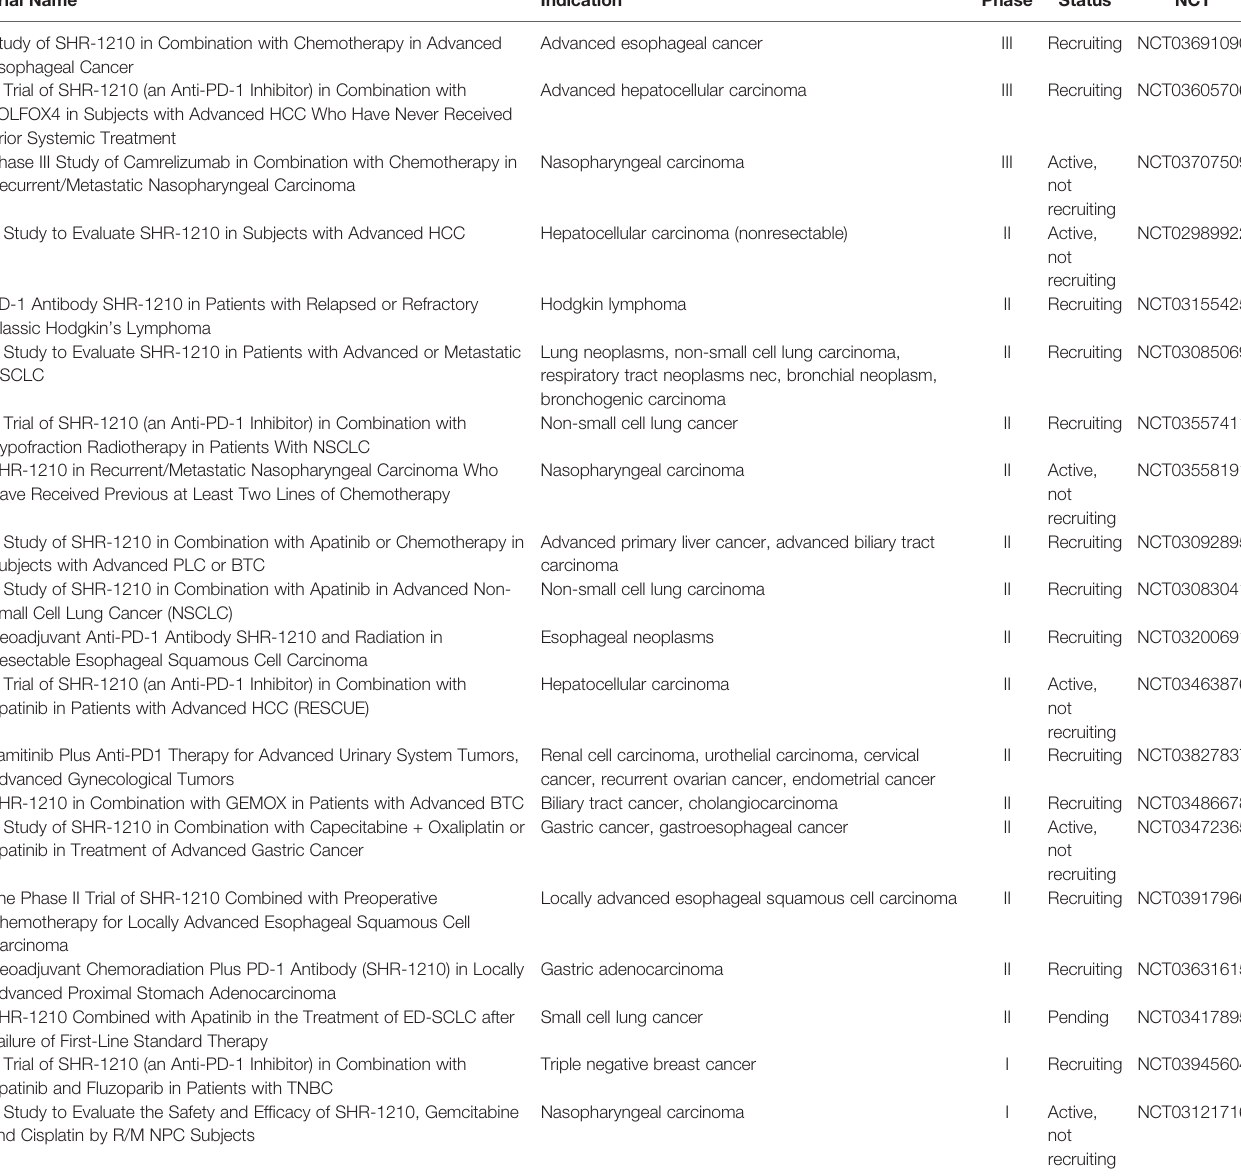
TABLE 1 | Key ongoing clinical trials of camrelizumab in